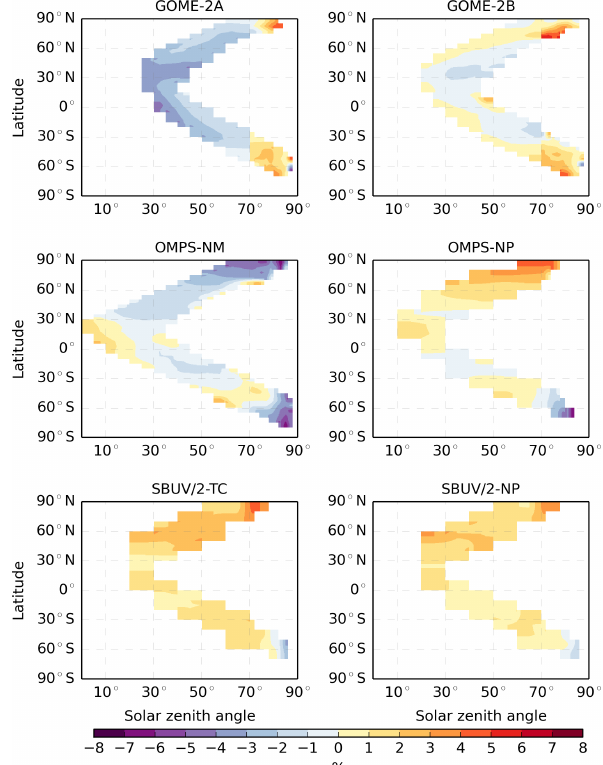
Figure 2. Mean total column ozone differences (%) between GOME-2A/B, OMPS-NM/NP, SBUV/2-TC/NP and colocated OMI-TOMS data for the period of July–August 2014. The SBUV/2- TC total column ozone values stem from the two-wavelength re- trieval, while those for SBUV/2-NP are the sums of the retrieved 21-layer partial columns. The colours blue to purple denote nega- tive differences and the colours yellow to red refer to positive dif-